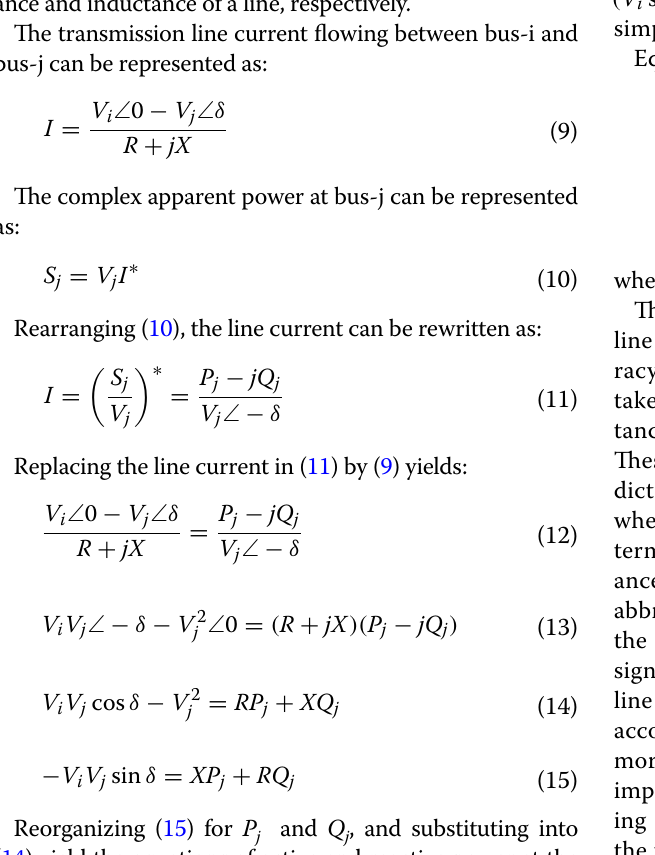
respectively. The angle ( δ ) represents the voltage angle dif- ference between the sending voltage angle ( δ i ) and the receiving voltage angle ( δ j ). The sending voltage is taken as a reference so its angle is zero. P i and Q i illustrate the active and reactive power at the sending end, while P j and Q j depict the active and reactive power at the receiving end, respectively. Z , R and X represent the impedance, resist- ance and inductance of a line,